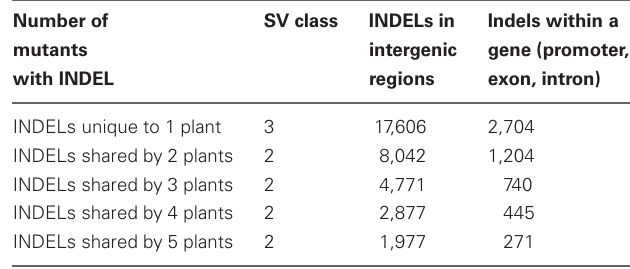
Table 4 | Identification and classification of SNPs in the five mutant plants.